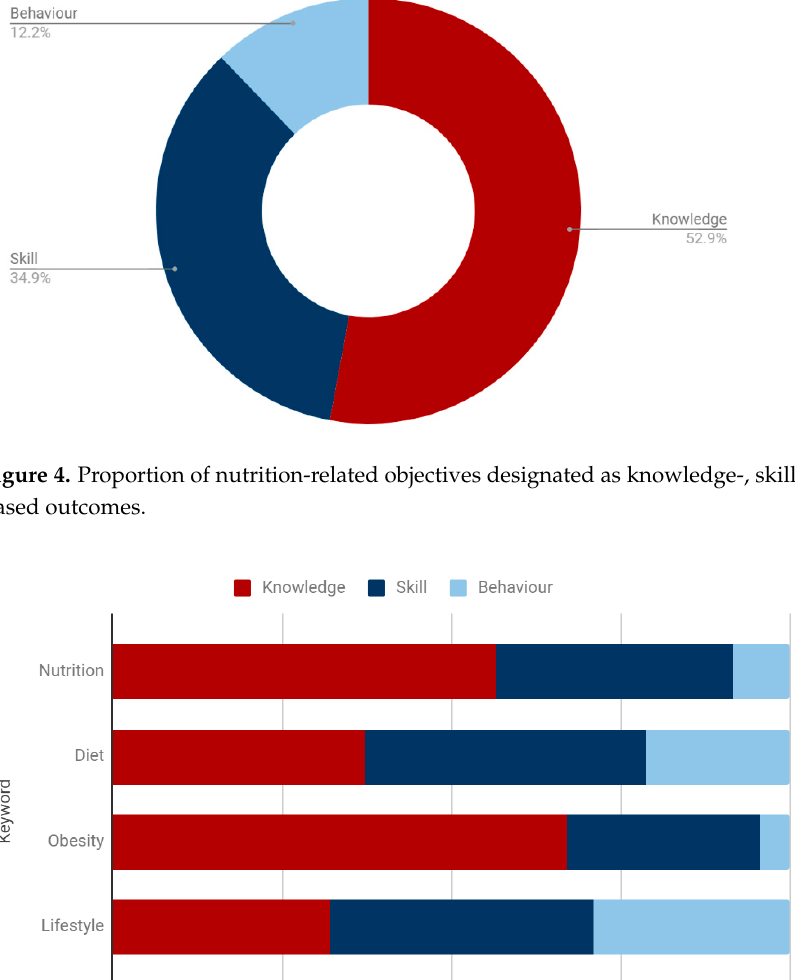
8 of 21 Figure 3. Number of nutrition-related modules per keyword across specialties.